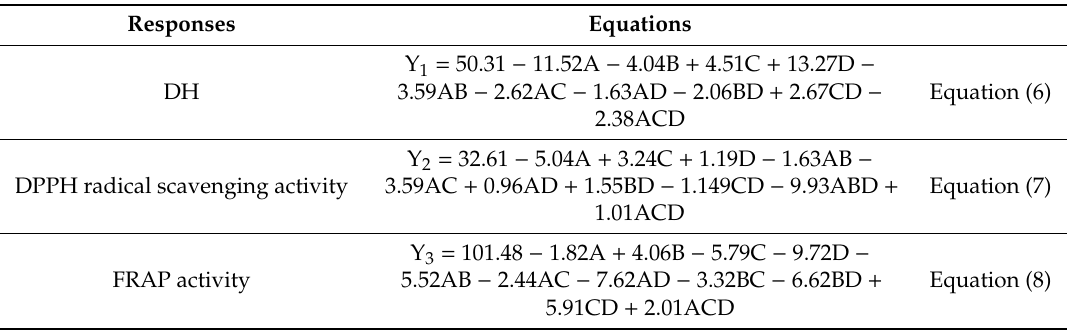
Table 4. Quadratic polynomial equations for the three